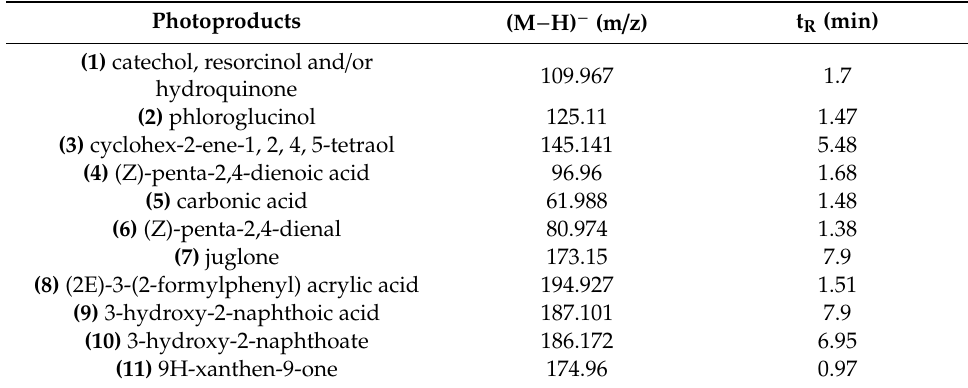
Figure 12. HPLC–MS mass spectra of phenol photoproducts. Table 5. HPLC–MS data for phenol photoproducts in the photocatalyzed decomposition of phenol over titania-coated metal composites under UV and Vis irradiation.